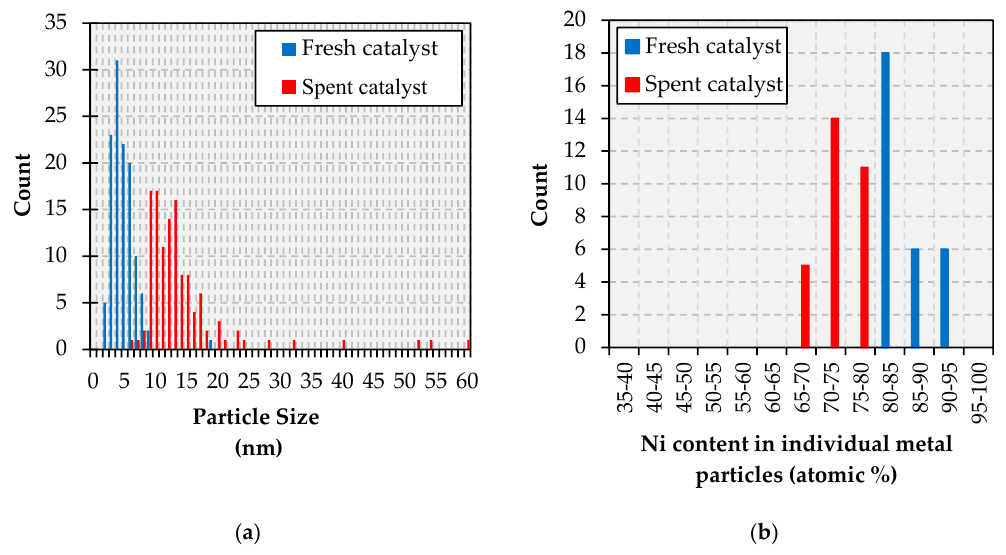
Figure 6. Particle size distribution ( a ) and metallic composition ( b ) histograms for the Ni-Cu catalyst. In the case of the Fe-promoted catalyst, TEM results indicate that a similar particle size change takes place during reaction. Indeed, the particle size distribution—which is narrow in the fresh catalyst as the vast majority of particles range from 3 to 7 nm—is both broader and shifted to larger (8–30 nm) particles in the spent formulation (see Figure 7a). However, the composition of the metal particles does not change much during the reaction in contrast with the Cu-promoted catalyst; the only change observed being the disappearance of Ni-rich (90–100% Ni) particles according to the TEM-EDS results in Figure 7b. These observations are illustrated by the TEM micrographs and the TEM-EDS elemental maps in Figure A10, which show the degree of association between Ni and Fe in both the fresh and the spent catalyst. The Fe maps included in Figure A10 also evince Fe-hollow spaces on both the fresh and spent formulation, albeit the latter displays more of these spaces. Analogous to the case of the Ni-Cu catalyst, Fe-hollowing may occur through a mechanism based on the Kirkendall effect, which has also been reported for Ni-Fe bimetallic formulations [38,39].